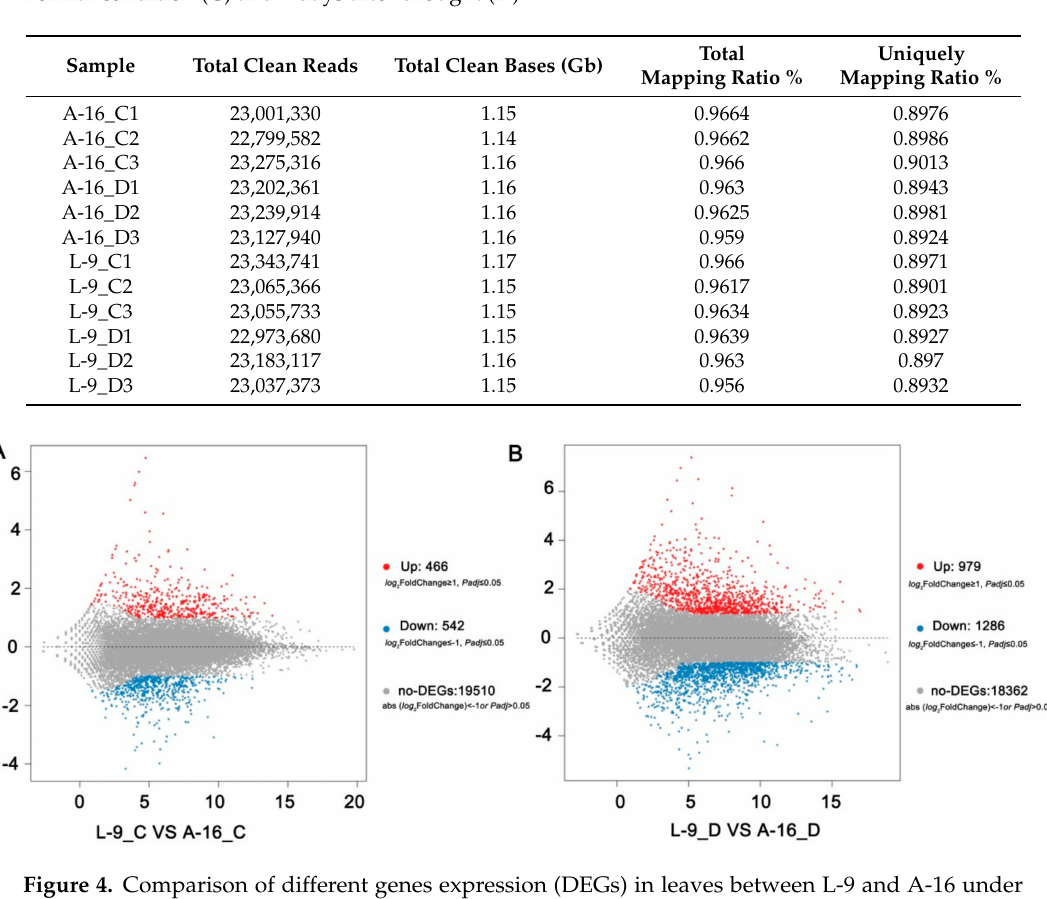
Figure 4. Comparison of different genes expression (DEGs) in leaves between L-9 and A-16 under normal conditions ( A ) and 4 days after drought ( B ). x - and y -axes represent log2 values of gene expression. Red, brown, and blue correspond to up-regulated, unaltered, and down-regulated gene expression, respectively. If a gene was expressed in just one sample, its expression value in another sample was replaced by the minimum value of all expressed genes in normal and drought samples. The screening threshold is given at the top of the